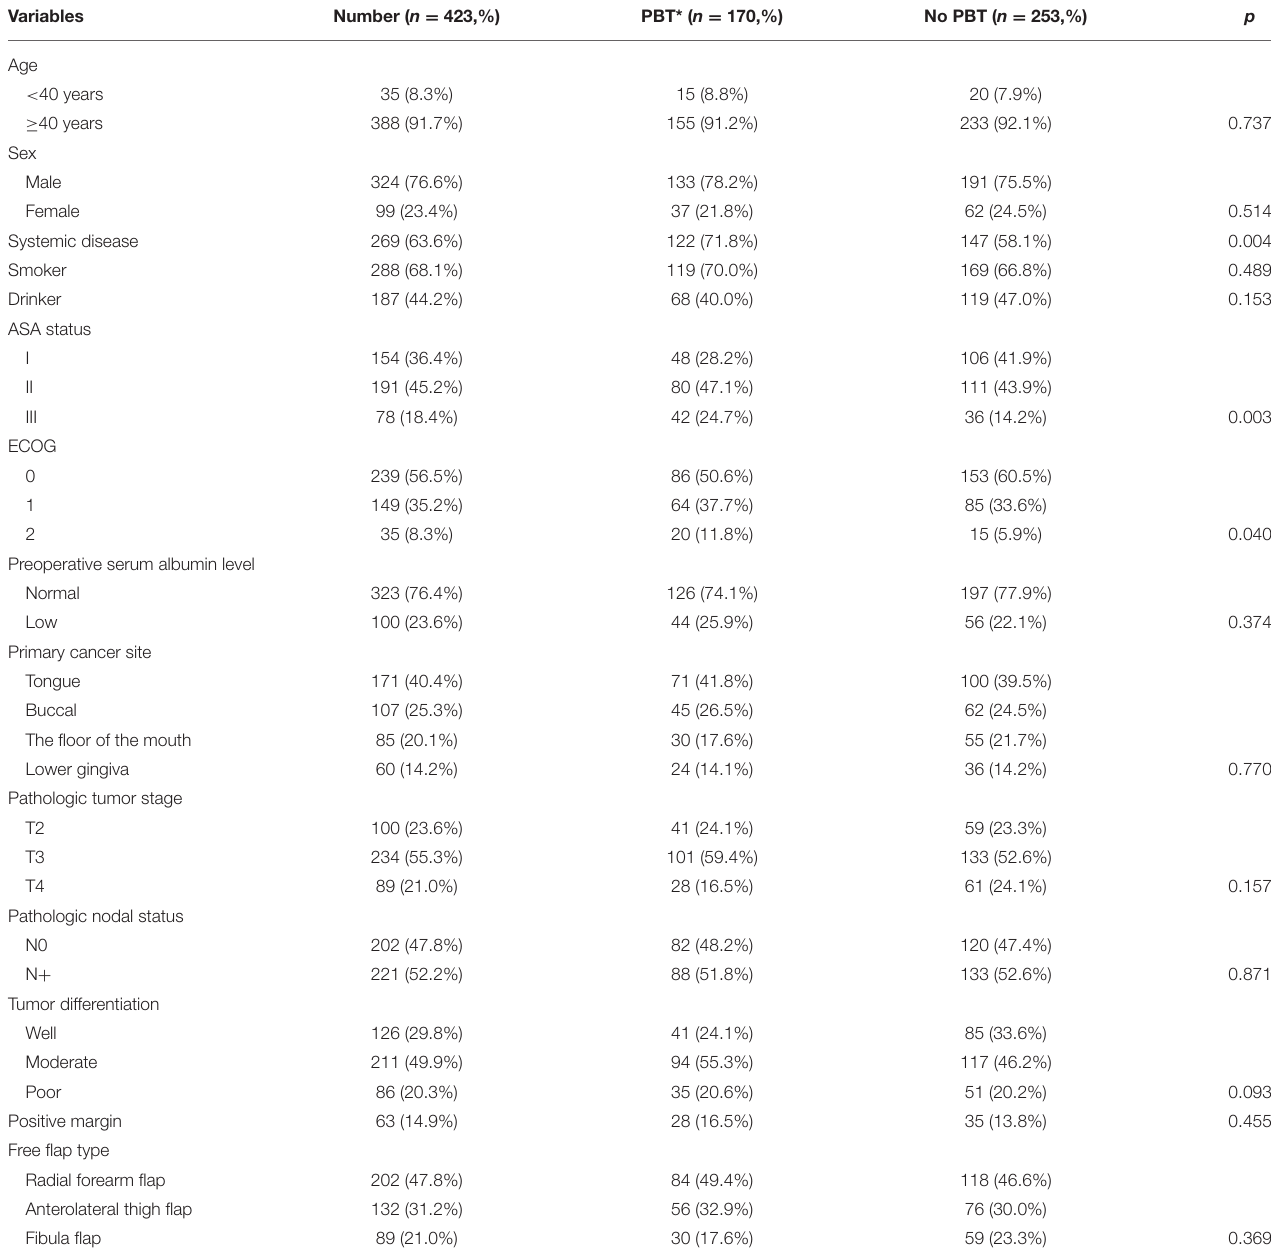
TABLE 1 | Demographic and pathologic information in the 423 enrolled